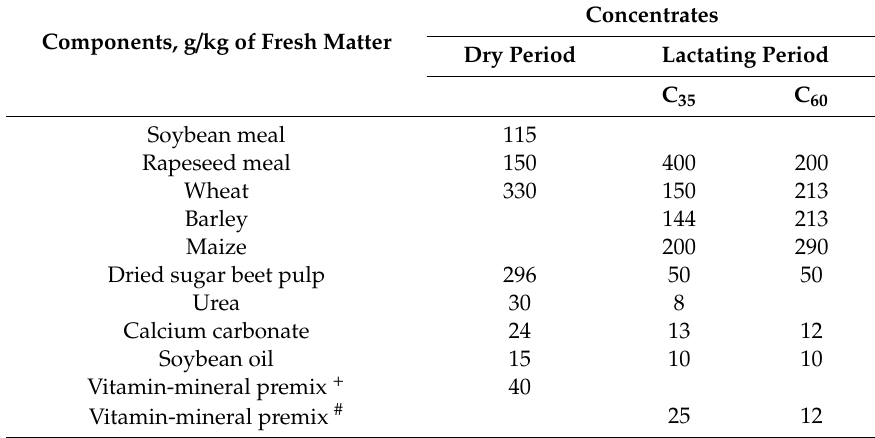
Table 1. Composition of concentrates during the dry and the lactating period. Components, g / kg of Fresh Matter